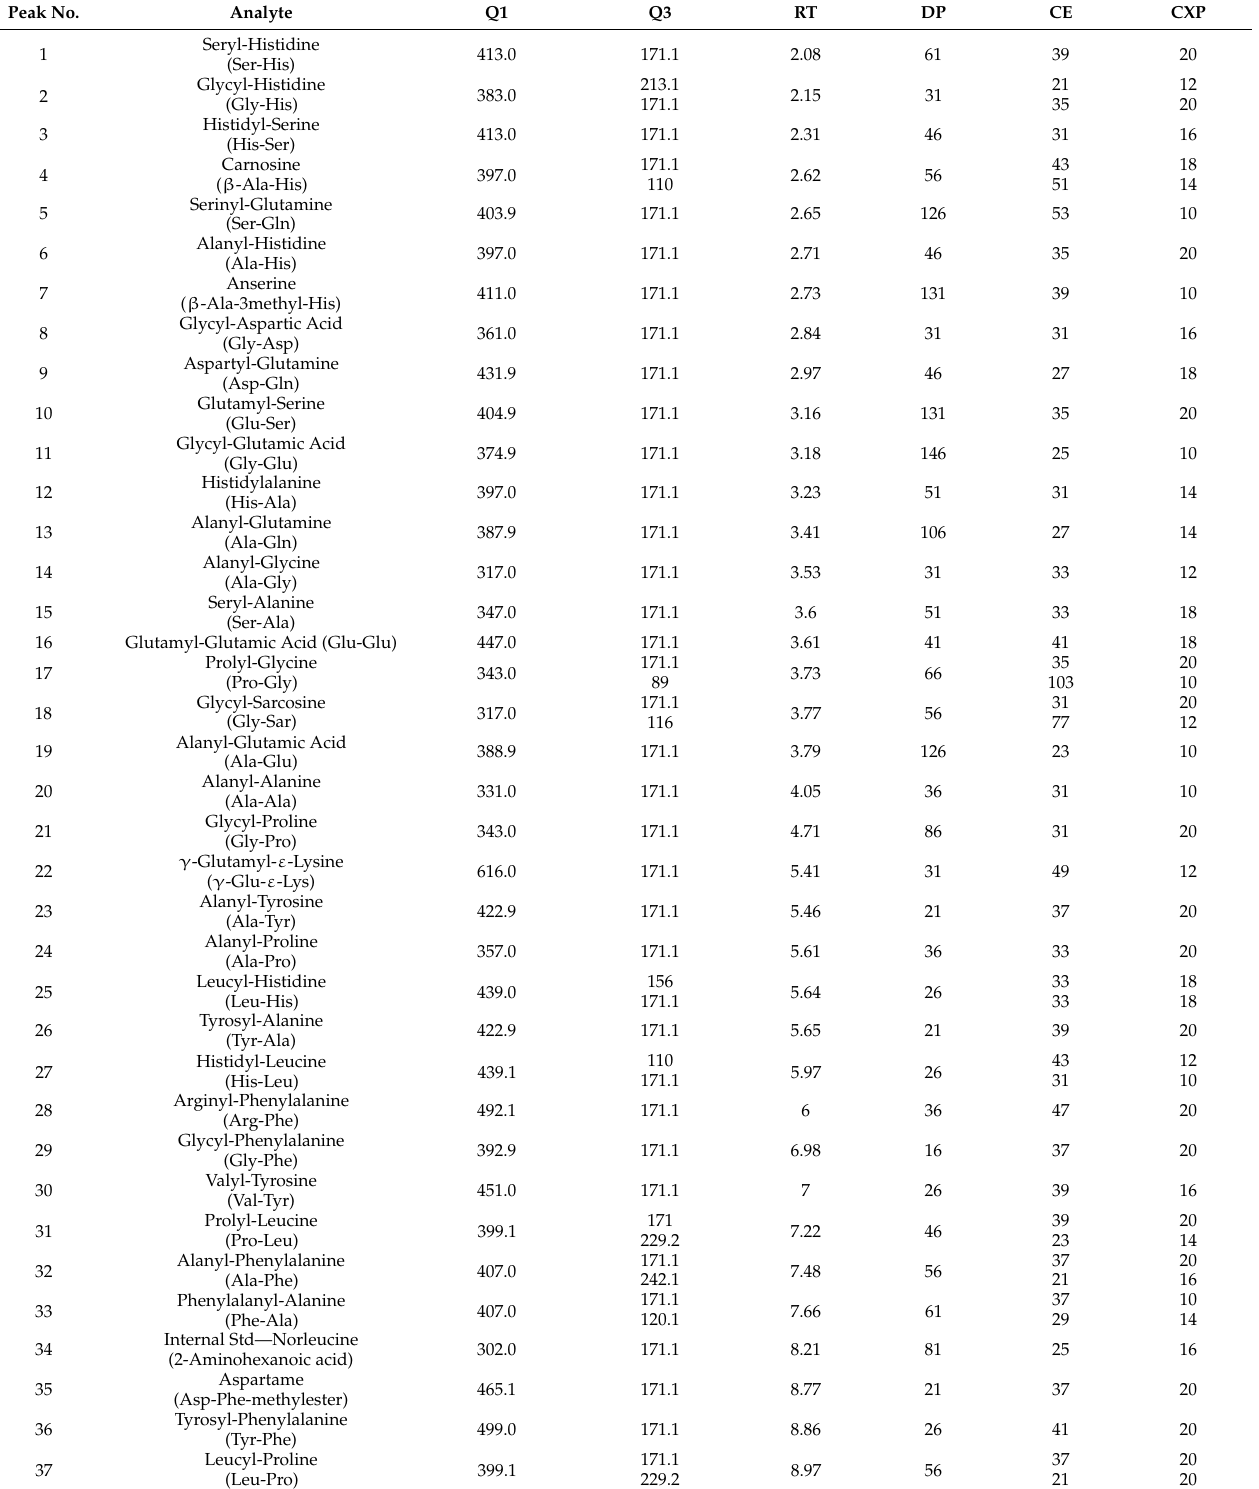
Table 1. Mass transitions (Q1 and Q3), retention time (RT), declustering potential (DP), collision energy (CE) and collision cell exit potential (CXP) for each analyte with peak